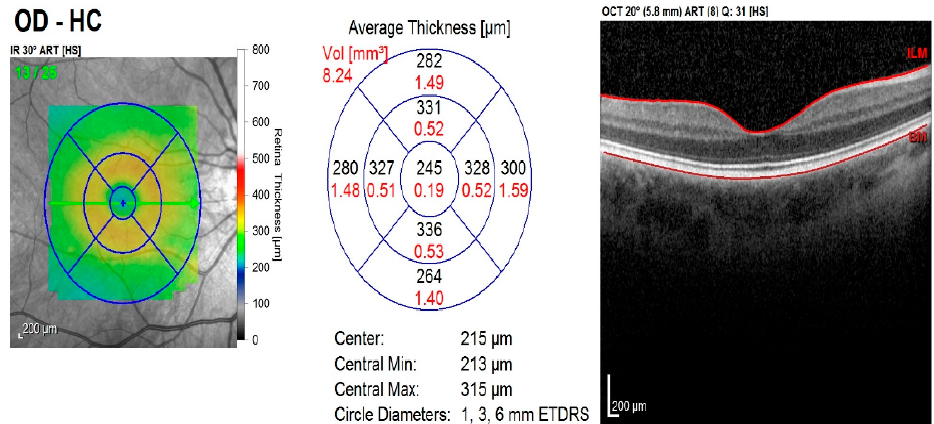
Figure 1. Macular OCT data acquisition from Spectralis Heidelberg SD–OCT device. In this particular case, both eyes have DME with cysts, disruption of the inner retinal layers, small hyperreflective foci, EZ disruption, and detachment of the neuroepithelium. Upper images (OD and OS) belong to the same DME patient with T2DM. The lower image, “OD-HC”, represents a macular OCT scan from a healthy subject (normal macular aspect). Abbreviations: OD—oculus dexter; OS—oculus sinister.